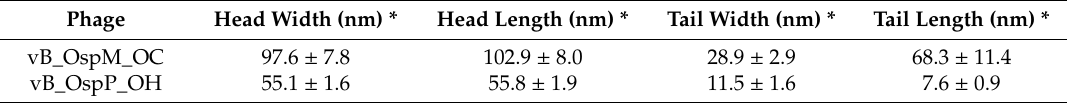
Table 1. Sizes of the heads and tails of the isolated Ochrobactrum phages.